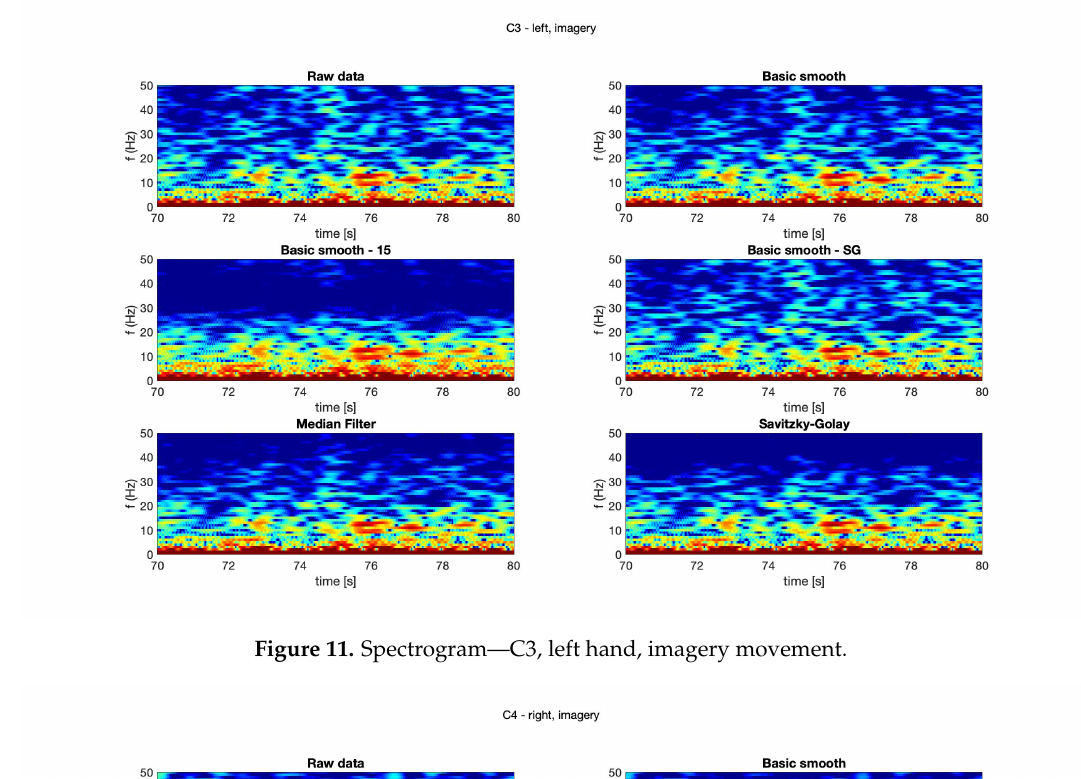
Figure 11. Spectrogram—C3, left hand, imagery movement.